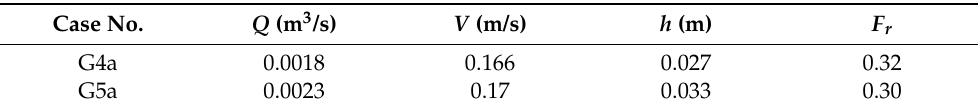
Table 1. Initial and boundary conditions for the experimental cases used in model calibration and